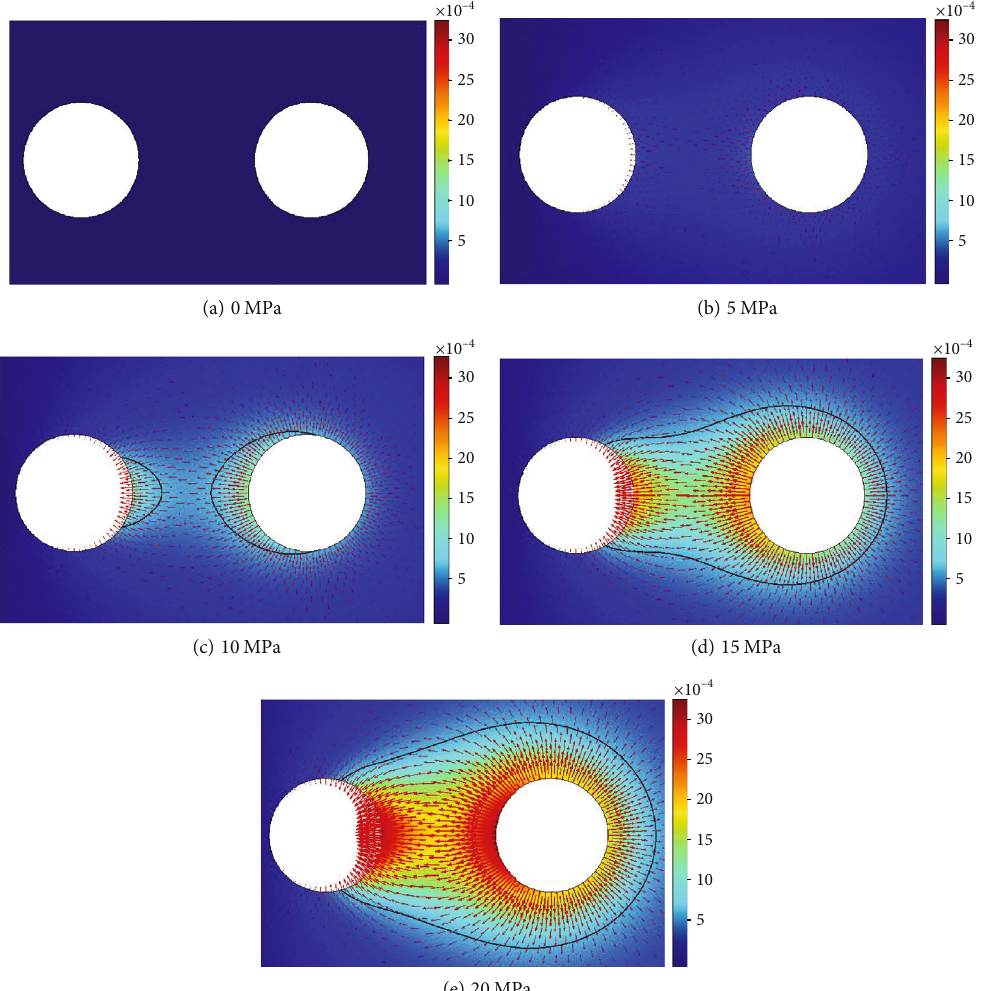
Figure 16: Velocity distribution of di ff erent karst caves after water pressure excavation (unit: